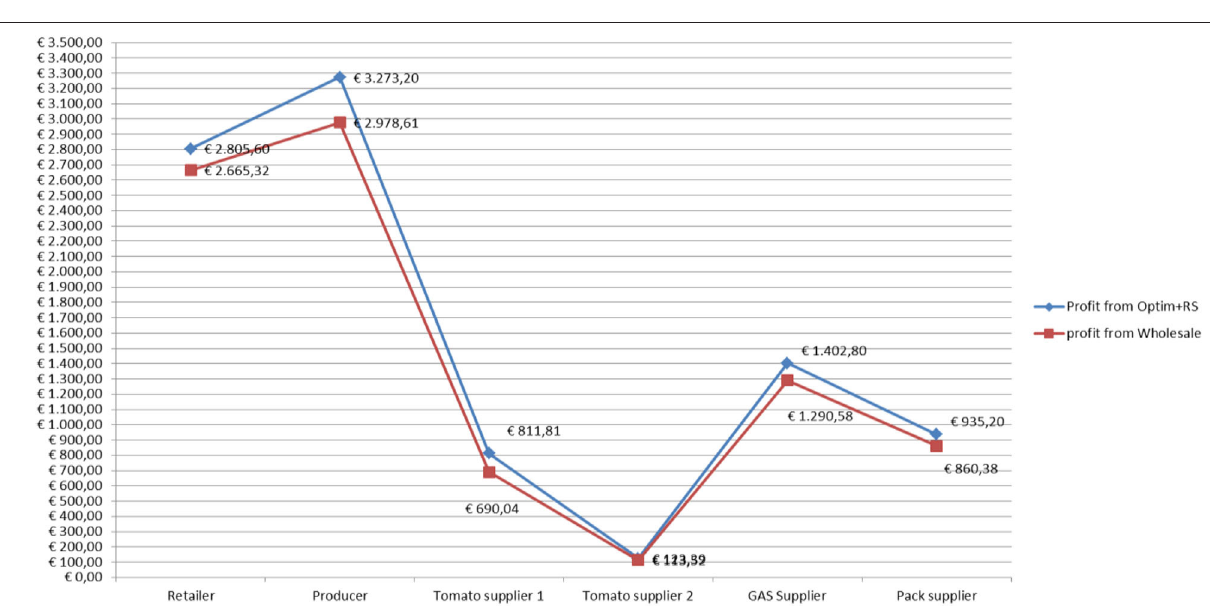
FIGURE 3 | Comparison of supply chain profits from the wholesale approach and from vertical integration with Revenue Sharing adopted by “Tomato supplier